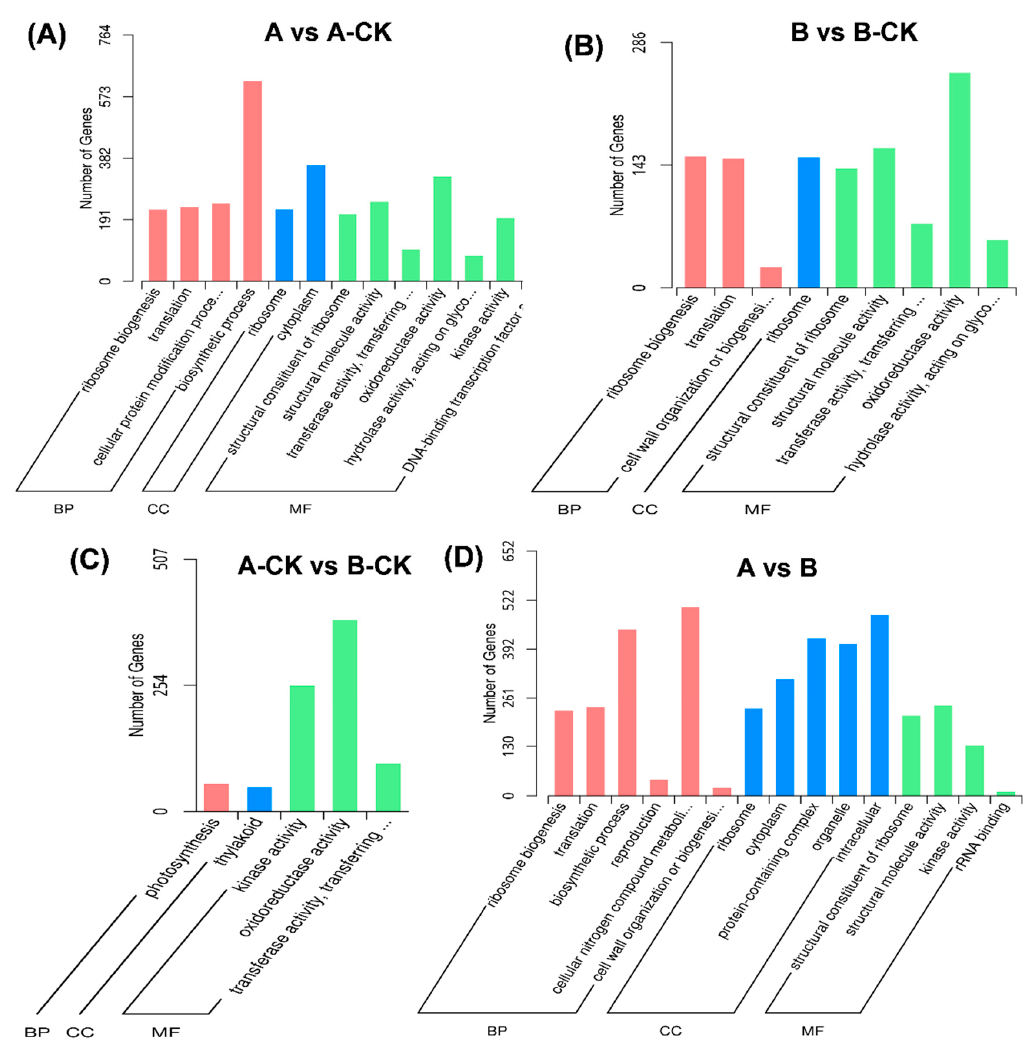
Figure 3. Gene Ontology (GO) classifications of differentially expressed genes. The differentially expressed genes were grouped into three hierarchically stretched GO terms, biological process (BP), cellular component (CC), and molecular functions (MF). ( A ) Comparison between A and A-CK, ( B ) Comparison between B and B-CK, ( C ) Comparison between A-CK and B-CK, ( D ) Comparison between A and B. Treatments: A-CK (Dawei-un-inoculated control), A (Dawei- inoculated with B. cinerea ), B-CK (Qiuxiang-un-inoculated control), B (Qiuxiang- inoculated with B. cinerea ).